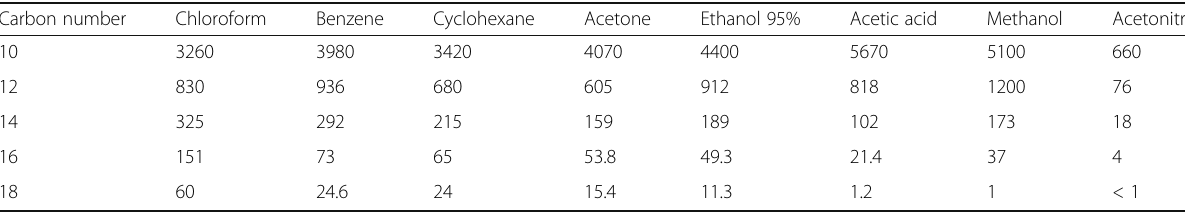
Table 8 Solubility data of fatty acids in organic solvents [g/L] Carbon